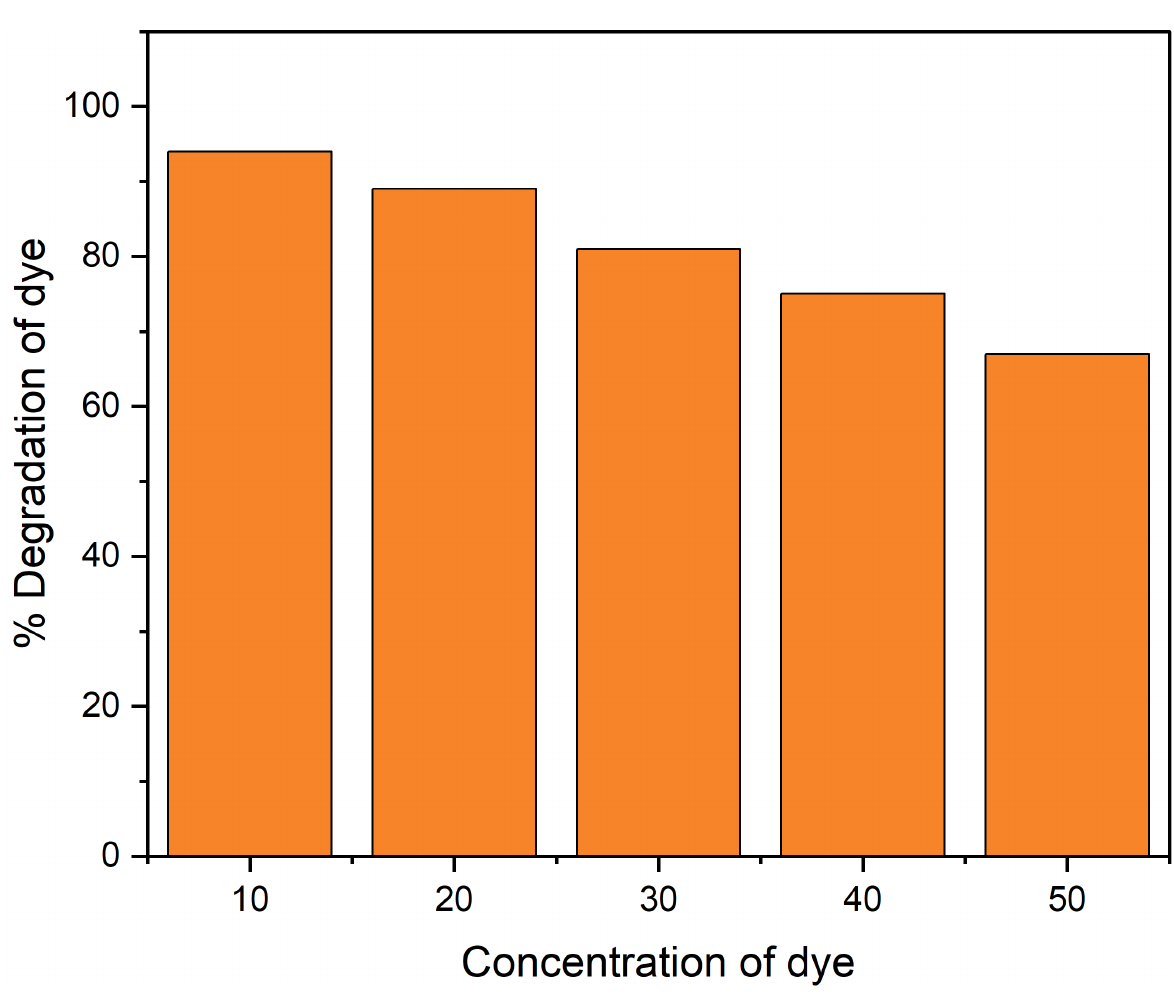
Figure 6. Dye concentration effect for the degradation of CR dye under UV light.